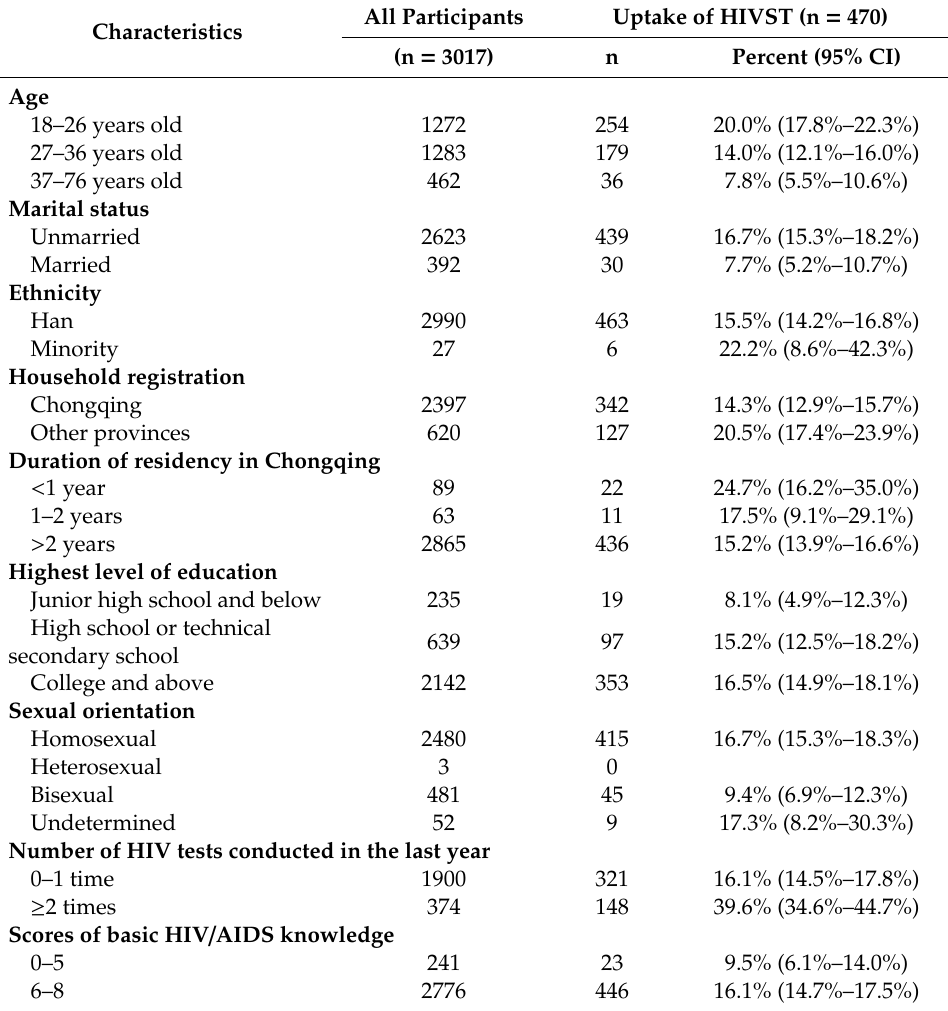
Table 2. Characteristics and HIV self-testing (HIVST) uptake of men who have sex with men (MSM) in Chongqing, China (n =